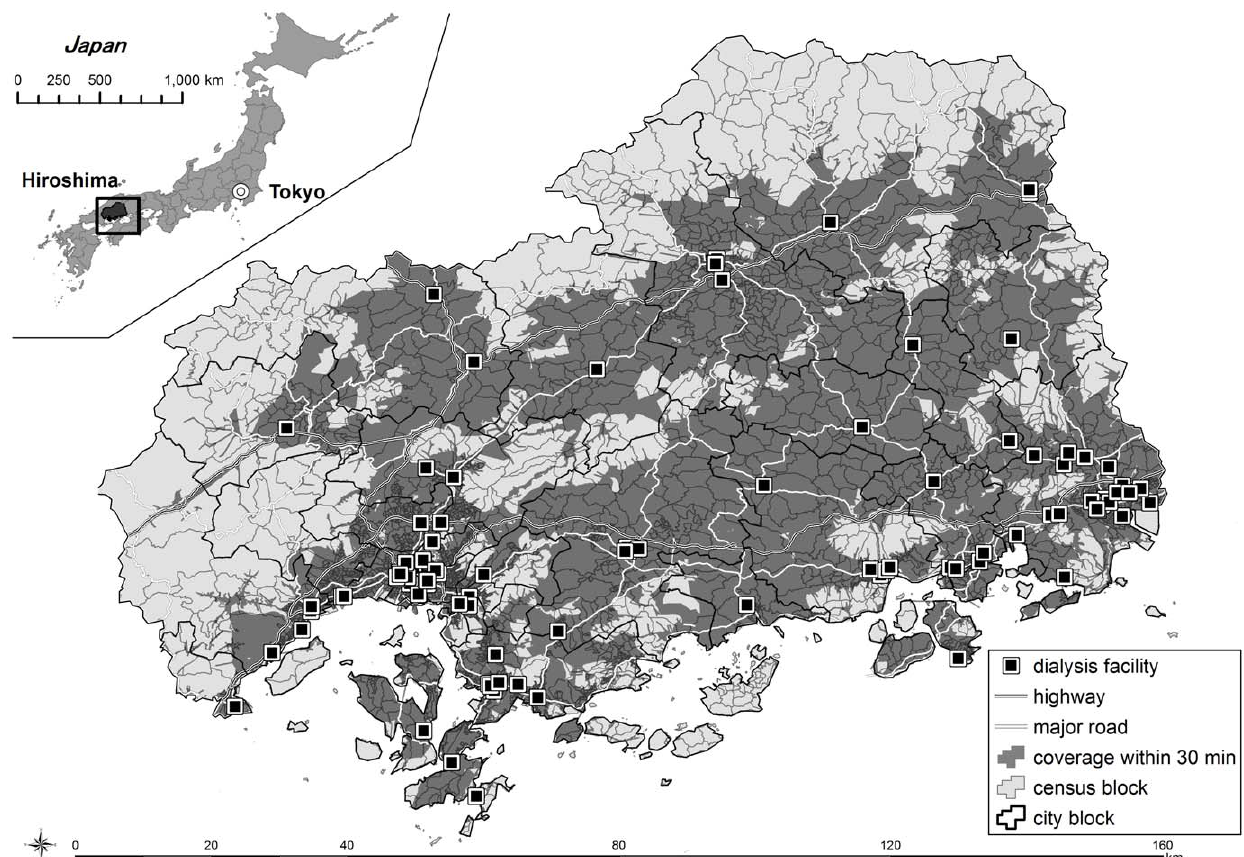
Figure 1. Map of Hiroshima prefecture with road network, coverage within 30 min from dialysis facility.